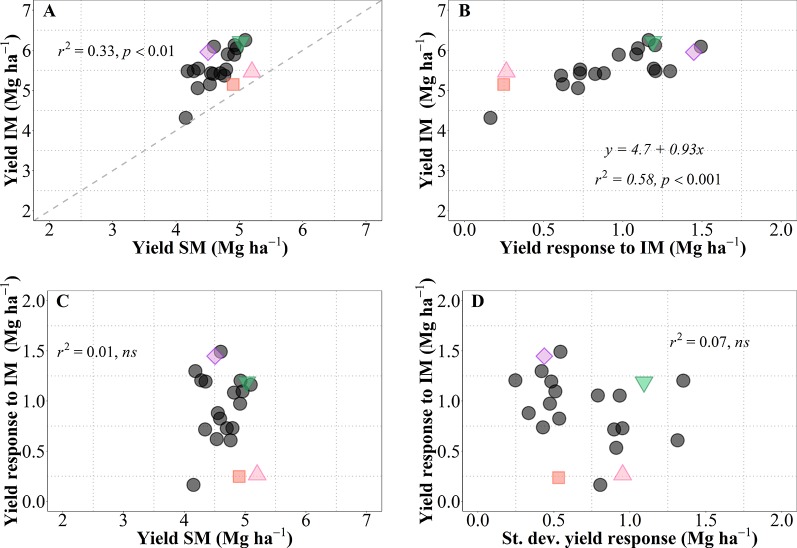
Relationship between mean yield under intensive (IM) versus standard management (SM) for the 21 genotypes tested averaged across site-years (A). Relationship between mean yield under IM and yield response to IM (i.e., yield IM minus yield SM) (B). Relationships between yield response to IM and either mean yield of SM (C), or standard deviation of the yield response to IM (D). The different symbols shows four genotypes selected to represent contrasting behaviors in terms of average responsiveness to intensive management (IM) and in stability of that responsiveness across all site-years selected genotypes, Zenda (triangle), Larry (inverted triangle), 1863 (square), and WB4458 (rhombus).